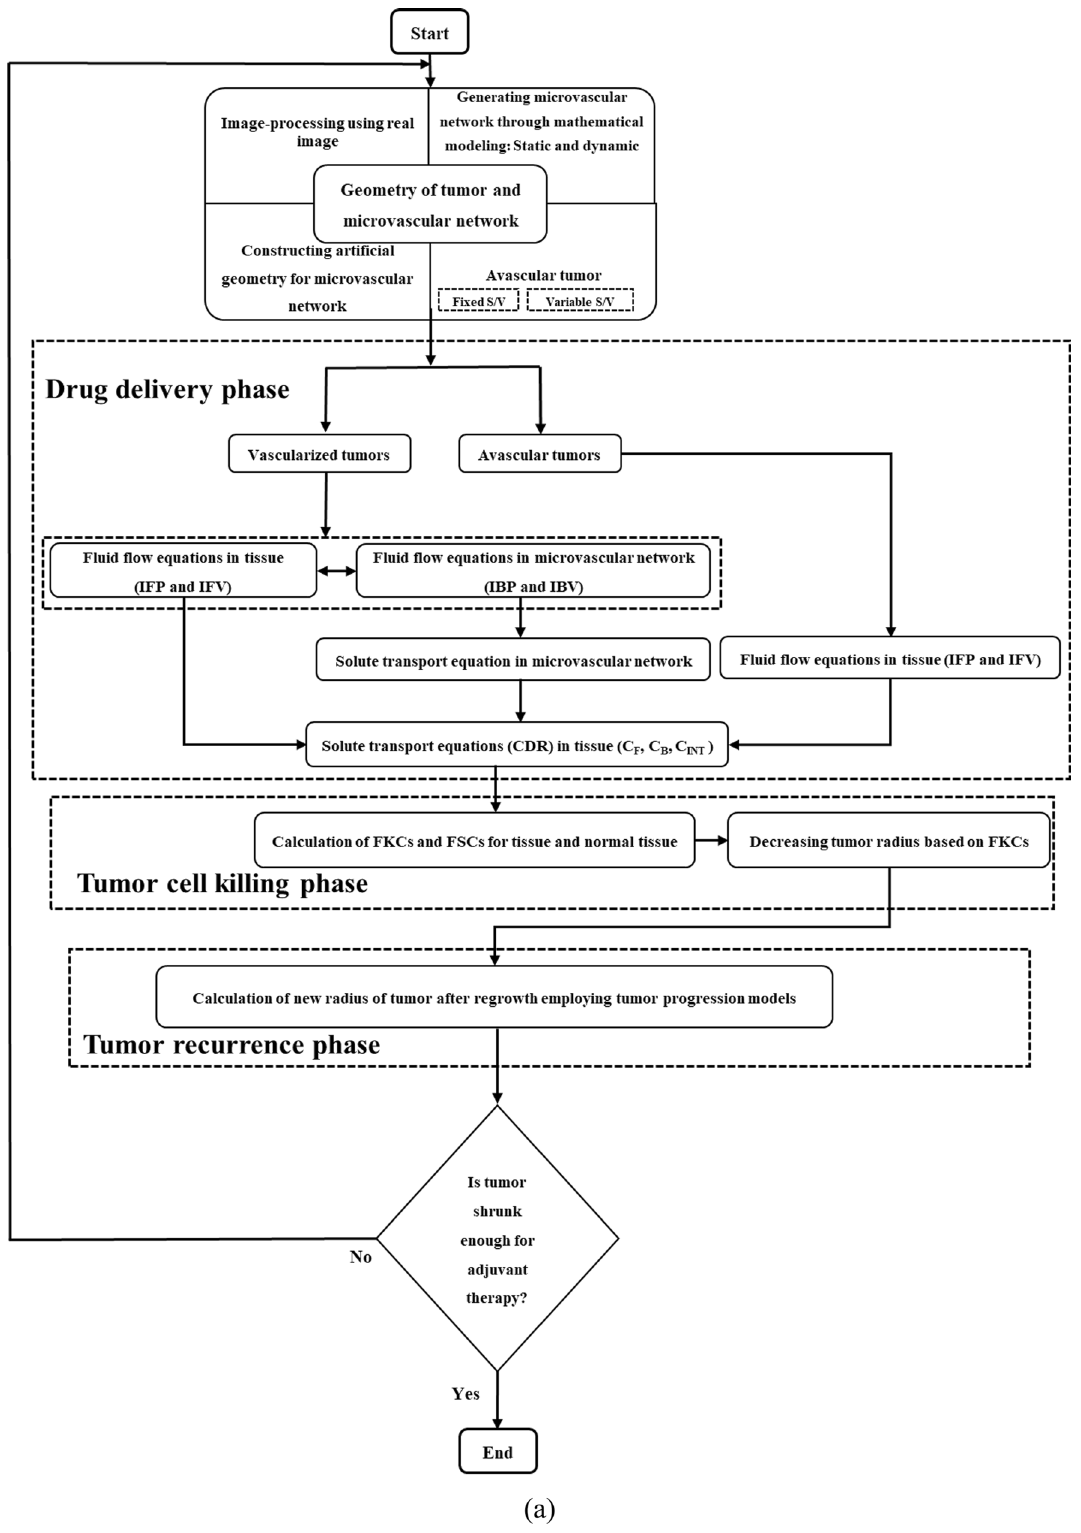
Figure 5. Integrated and comprehensive computational approach presented for evaluating solid tumor treatment. ( a ) Flowchart of novel approach proposed for assessing efficacy of sequential treatment cycles; ( b ) Different phases of modeling for a single treatment cycle on the present case study for drug DOX, including geometry generation phase, drug delivery phase, and tumor cell killing phase. It is worth-mentioning that the right-hand side figure demonstrates a comparison of the results of this study with Stylianopolous et al. 36 ; ( c ) A schematic of proposed approach based on sequential treatment cycles and tumor recurrence between two consecutive treatments for evaluating different treatment